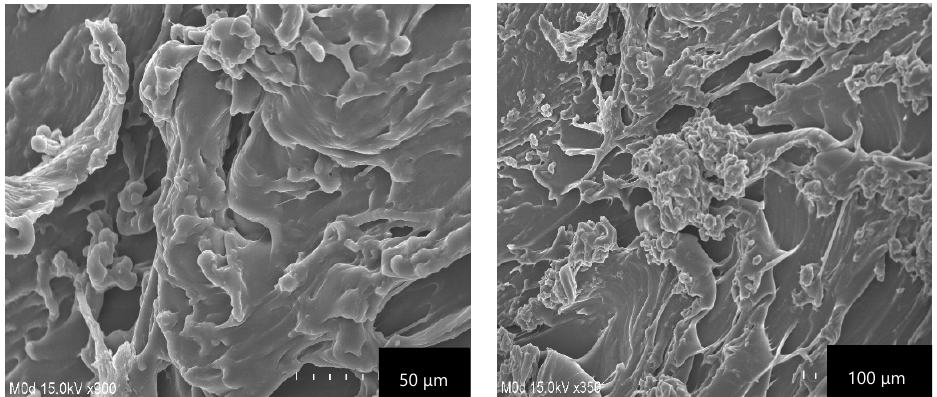
Figure 6. Scanning electron microscopy of CS/ β -CDcPAa hydrogel.